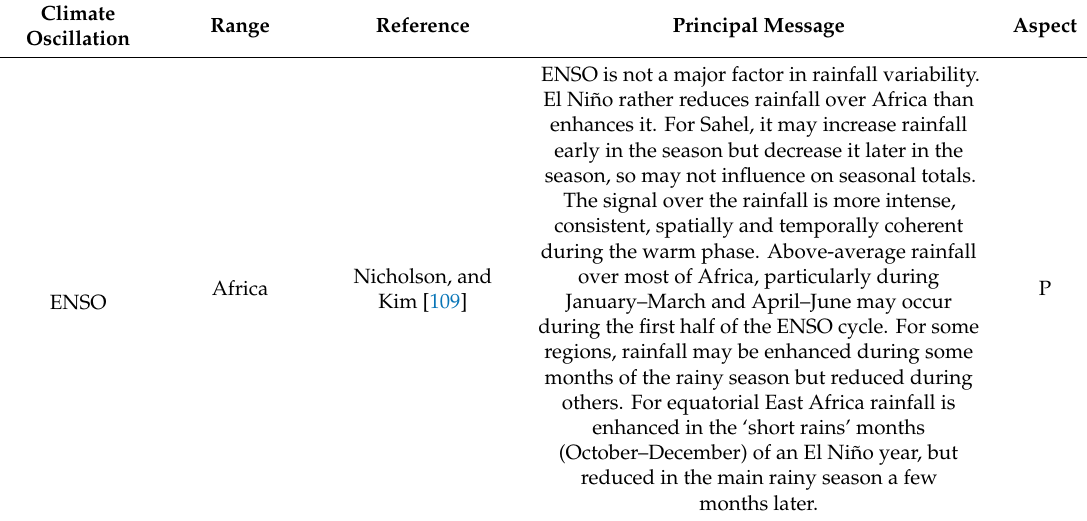
Table 8. Review of links between climate oscillation and floods for Africa, as reported in the literature. Aspects of reference in the rightmost column—as in Table